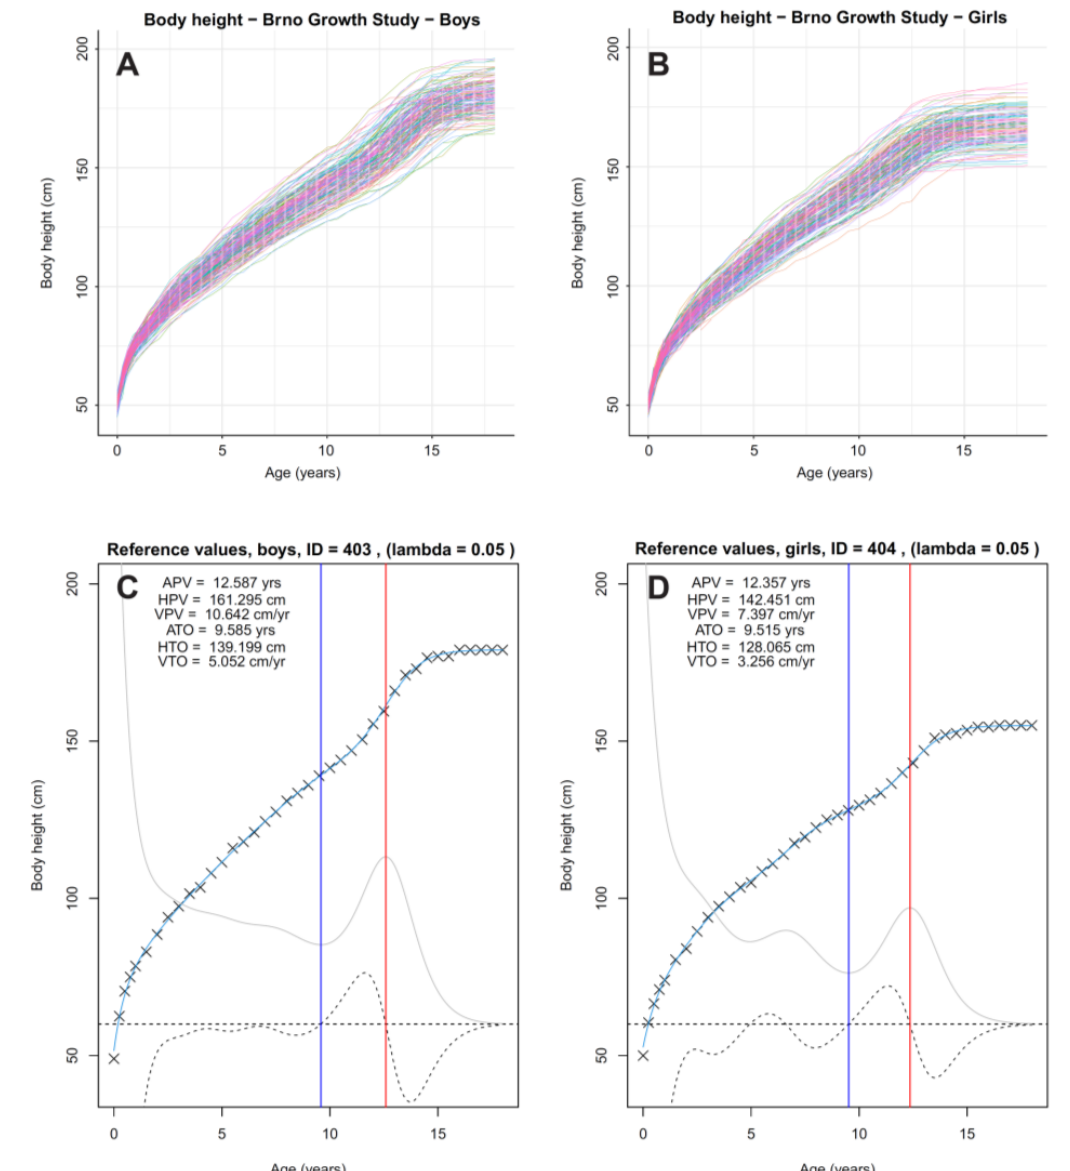
Figure 2. Individual longitudinal data (points are connected by segments creating an impression of curves) for height of individual subjects from the Brno Growth Study for boys ( A ) and girls ( B ); two examples ( C ) a boy, ( D ) a girl of estimated growth milestones used as reference values: crosses—raw measurement, light blue solid line—distance curve (fitted B-spline), solid grey line—velocity curve (1st derivative of the distance curve), dashed grey curve—acceleration curve (2nd derivative of the distance curve), dashed horizontal line—zero value for velocity and acceleration curves (at value 60 of the y -axis), blue vertical—Age at Take-off (ATO), red vertical—Age at Peak Velocity (APV); to both velocity and acceleration values a constant (+60) was added and simultaneously they were multiplied by another constant (+5) to be visible in one data-dense plot and readable against the same y -axis of the distance